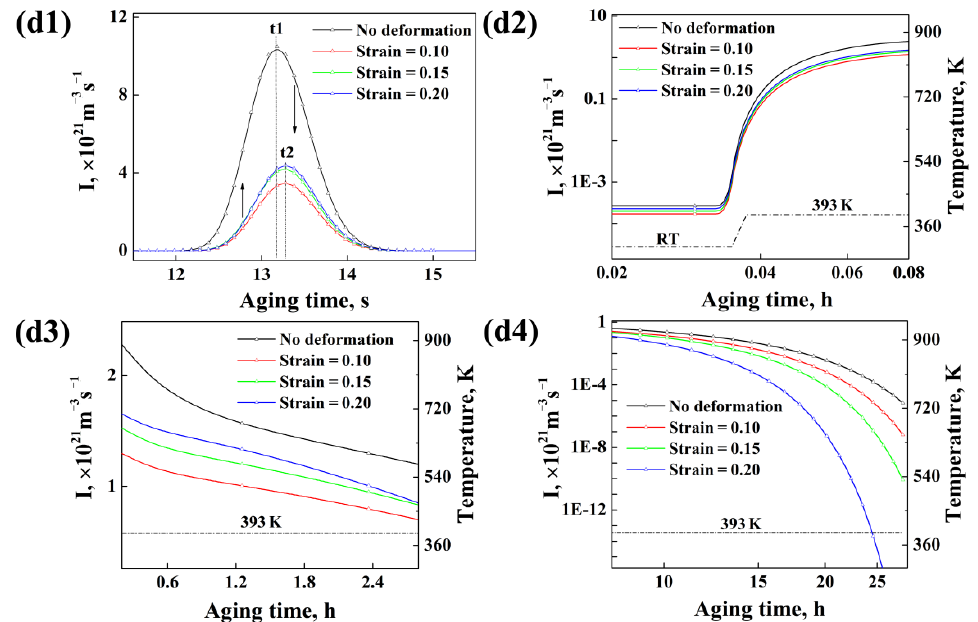
Figure 10. Details about the nucleation rate of precipitates for alloy samples with different strains (on the basis of Figure 9d).